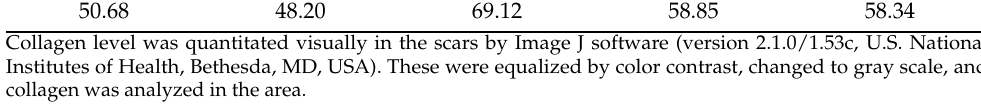
Figure 1. Patients with keloids in the earlobe. ( A – E ) were shown in order of increasing age.